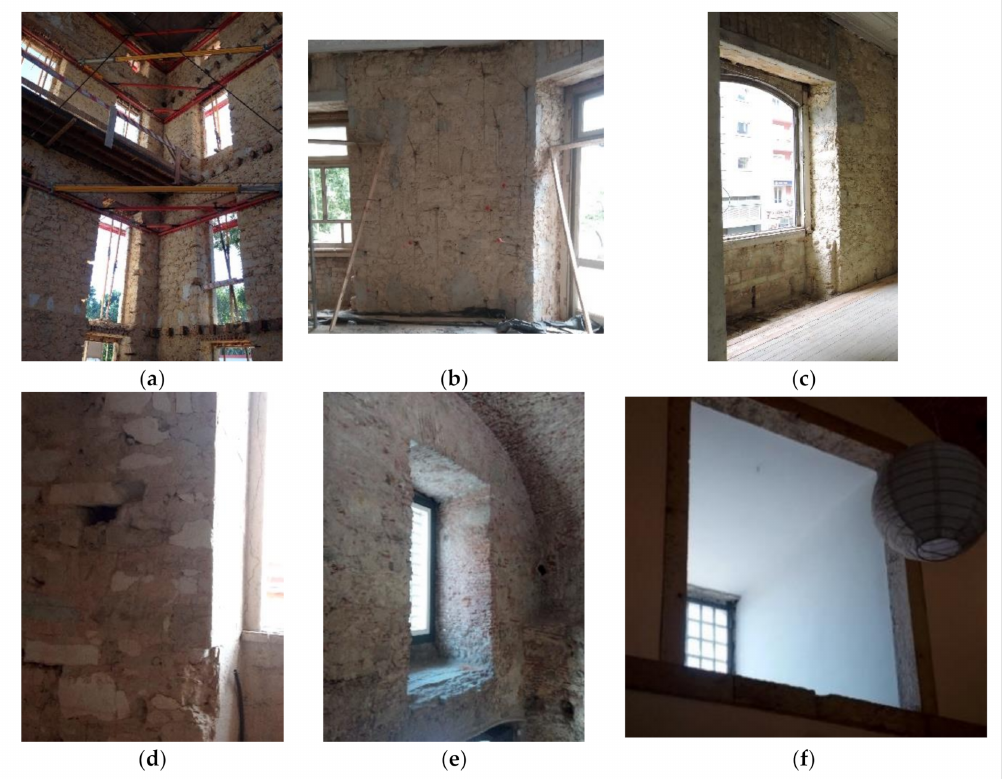
Figure 1. Examples of Portuguese facades from building built on periods of 1880–1930 ( a – d ) and before 1755 ( e , f